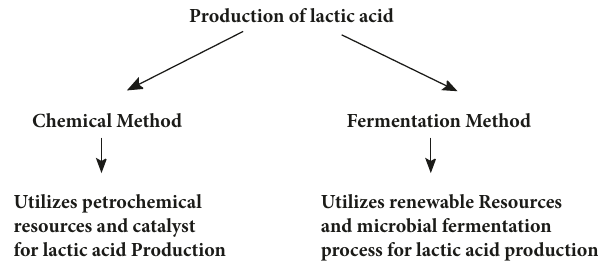
Figure 1: Methods of production of lactic